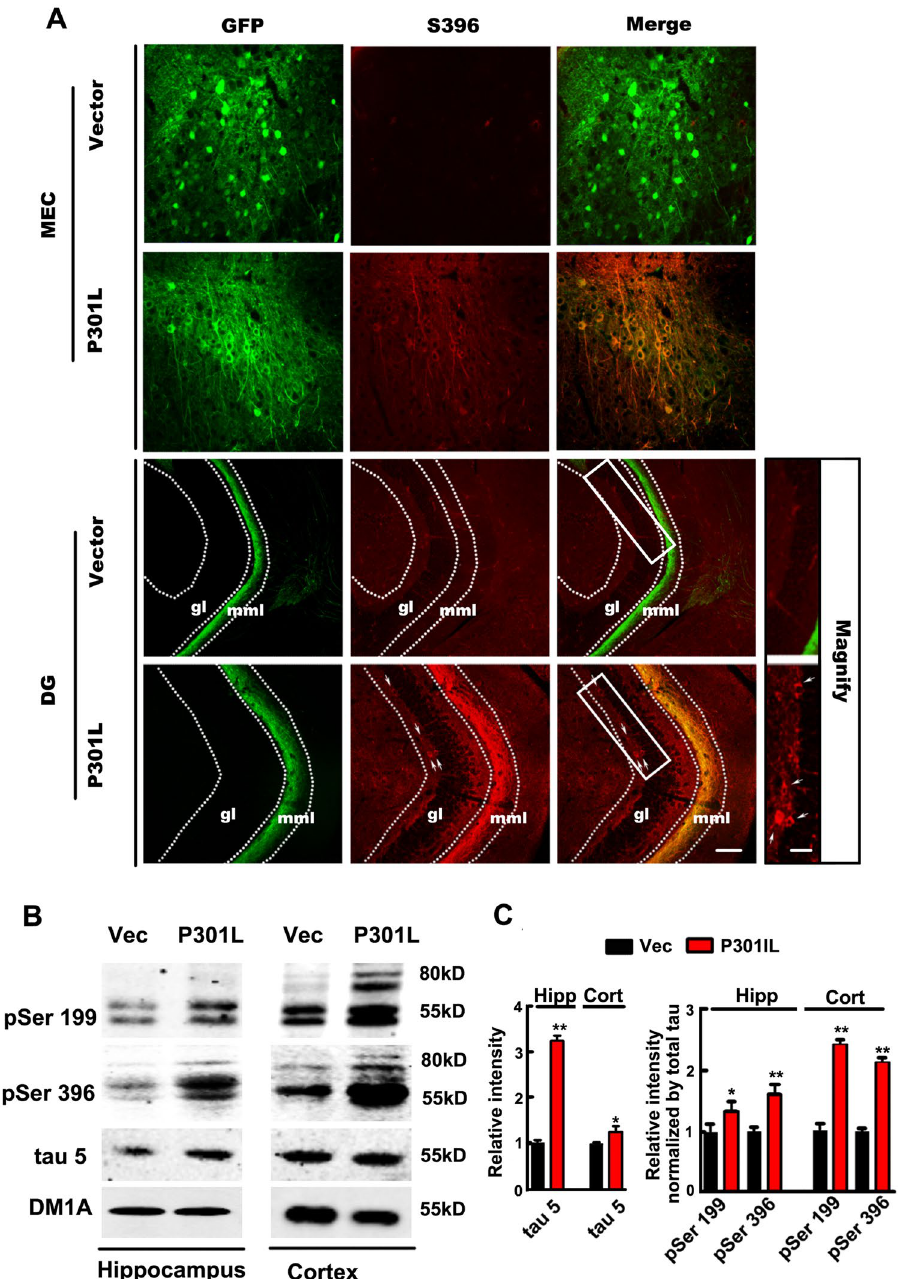
Figure 2. Expression of P301L hTau in MEC induces endogenous hippocampal tau hyperphosphorylation and accumulation. ( A ) Phosphorylation level of tau at Ser396 was significantly increased in MEC and its projection fibers to DG in brain slices one month after transduction of P301L hTau in MEC, where phosphorylated tau were co-localized with GFP. Interestingly, transduction of P301L hTau in MEC induced an increase of phosphorylated tau in the granular layer (gl) shown in magnified box, suggesting endogenous hippocampal tau hyperphosphorylation. ( B ) Western blotting showed that the phosphorylation of 55 kD tau at Ser396 or Ser199 was significantly increased in hippocampus and cortex, while only around 80 kD band (tau + GFP) was found in cortex of P301L mice. An increase of total tau probed by tau-5 suggested tau accumulation (n = 3 per group, * p < 0.05, ** p < 0.01). Blots of Ser396 and Ser199 were overexposed here for the expressions of exogenous GFP labeled tau was much less than internal tau. Cropped blots are displayed here and full-length blots are included in the supplementary information. Data were expressed as mean ±